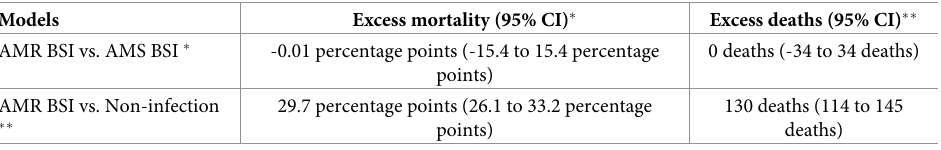
Table 4. Excess mortality and deaths among patients with AMR